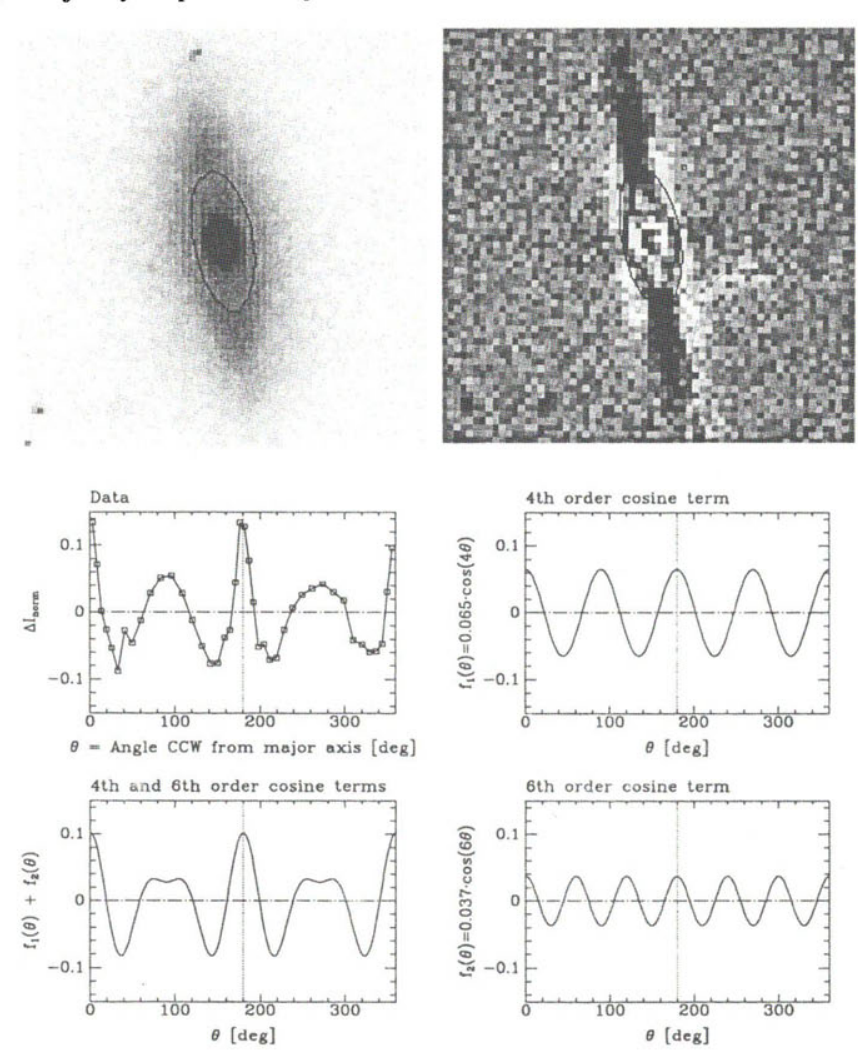
Fig. 6. Top: Original and residual images of the SO galaxy, with a single ellipse at a = 2.2 kpc (r = 1.4 kpc) shown. The images are 13 kpc on the side. The 'Data' plot shows A/ nor m versus 6 along the shown